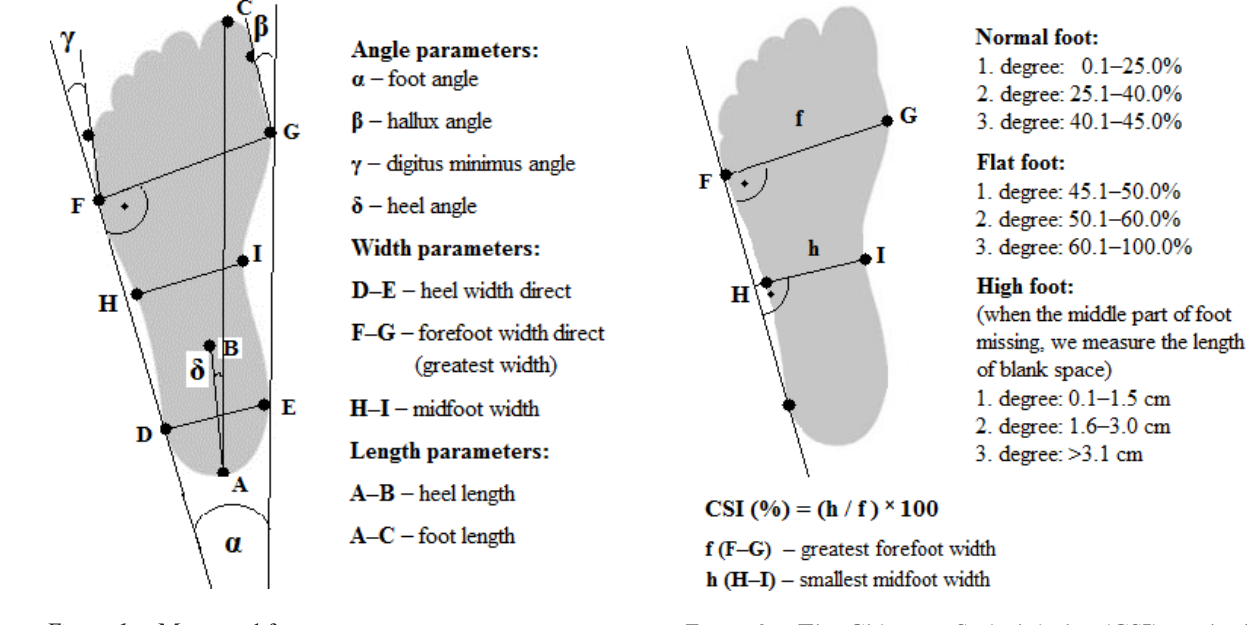
Figure 2. The Chippaux-Smirak index (CSI) method (modified from Přidalová & Riegerová, 2005)